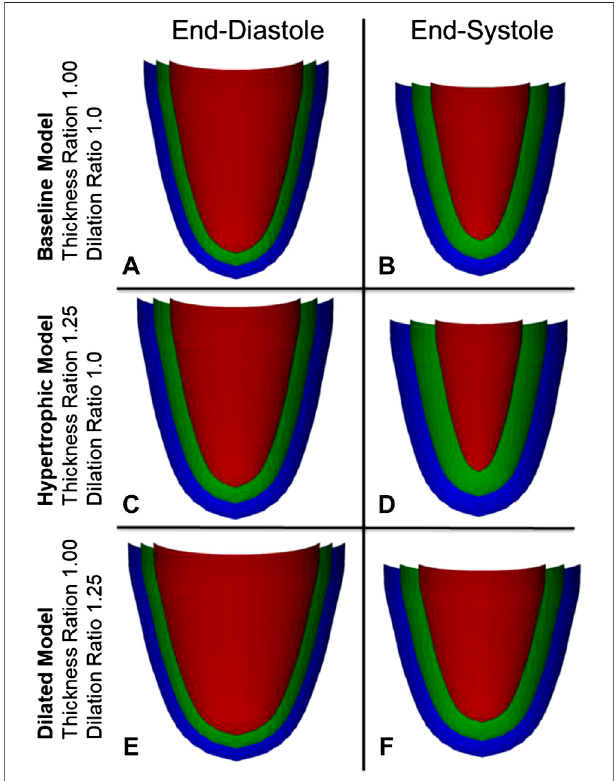
FIGURE 1 | Visualization of the myocardial numerical model at three layers, the endocardium (red), the mid-wall layer (green), and the epicardium (blue), for the (A,B) normal heart, and during (C,D) myocardial wall thickening and (E,F) chamber dilation